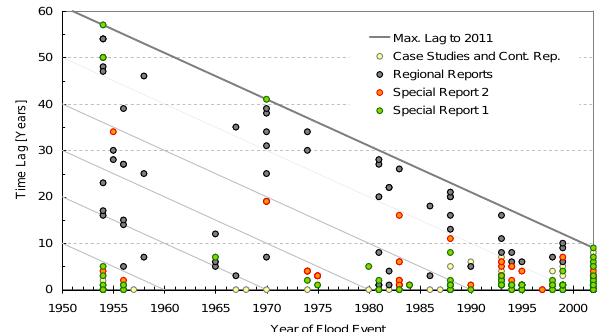
Fig. 6. Time lag between the year in which the document was pub- lished and the year of the flood event. For better orientation the diag- onals depict decadal isolines referring to the publication year (2011, dark line; 2000, 1990, 1980, 1970, 1960, light